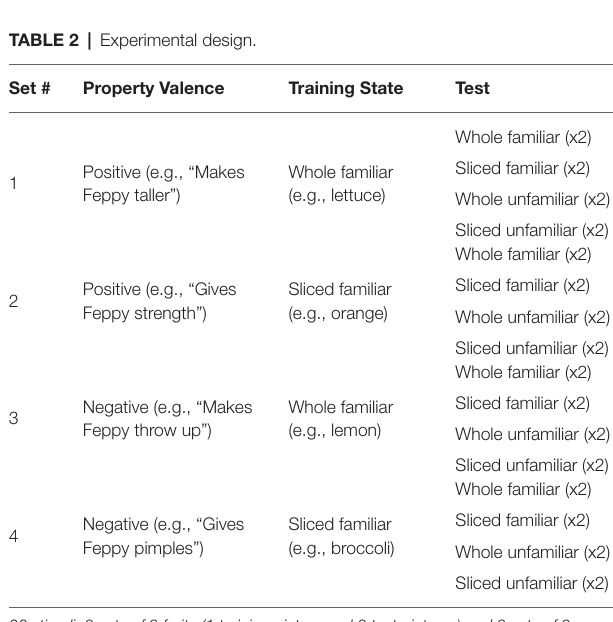
FIGURE 2 | Example of a set of fruit stimuli used in the property generalization task.